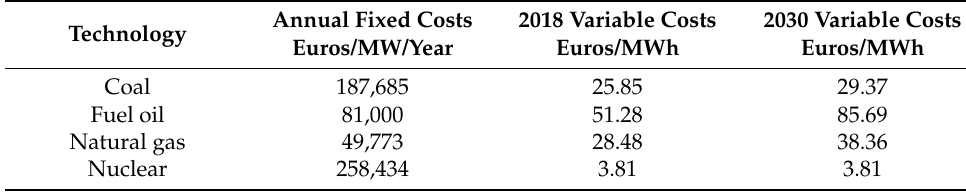
Table 2. Annual fixed and variable costs of the global thermal technologies.